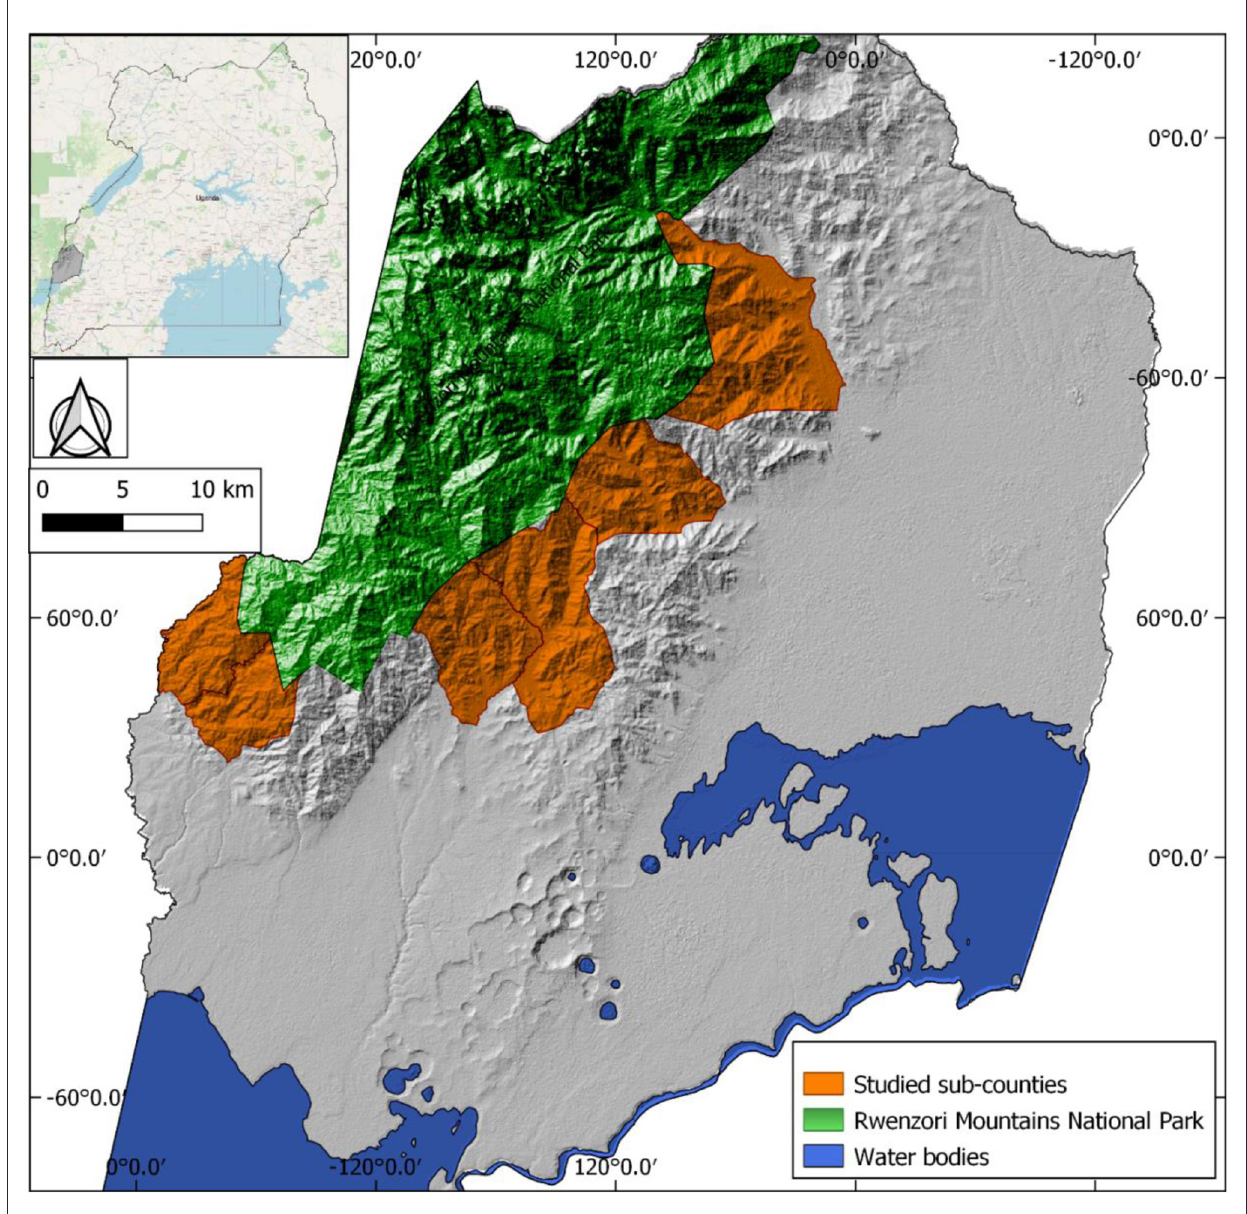
FIGURE2 The geographical area under